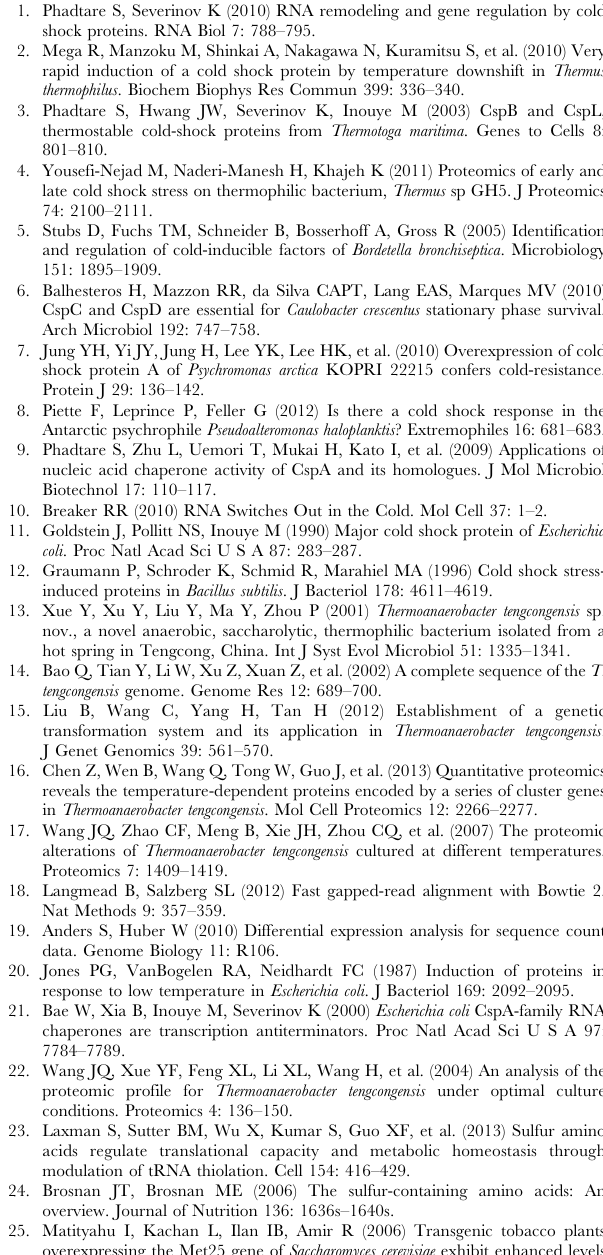
Table S4 Novel genes in TTECS identified by